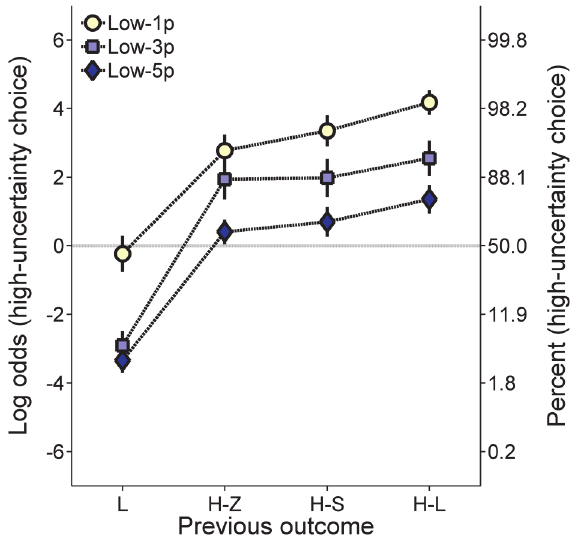
Fig 11. Mean ( ± SEM) log odds of high-uncertainty choices in the low-uncertainty magnitude training procedure of Experiment 3B as a function of the outcome of the previous choice and the outcome magnitude (pellets, p ) of a low-uncertainty outcome choice. A second ordinate showing percentages corresponding to the log odds values is included to aid interpretation.